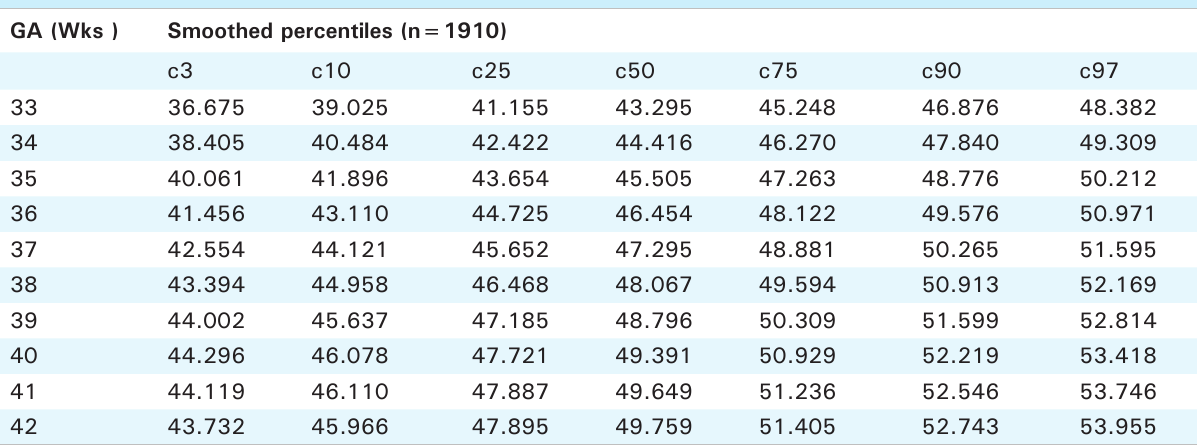
Table 3. Smoothed percentile values of CHL for each gestation from 33 to 42